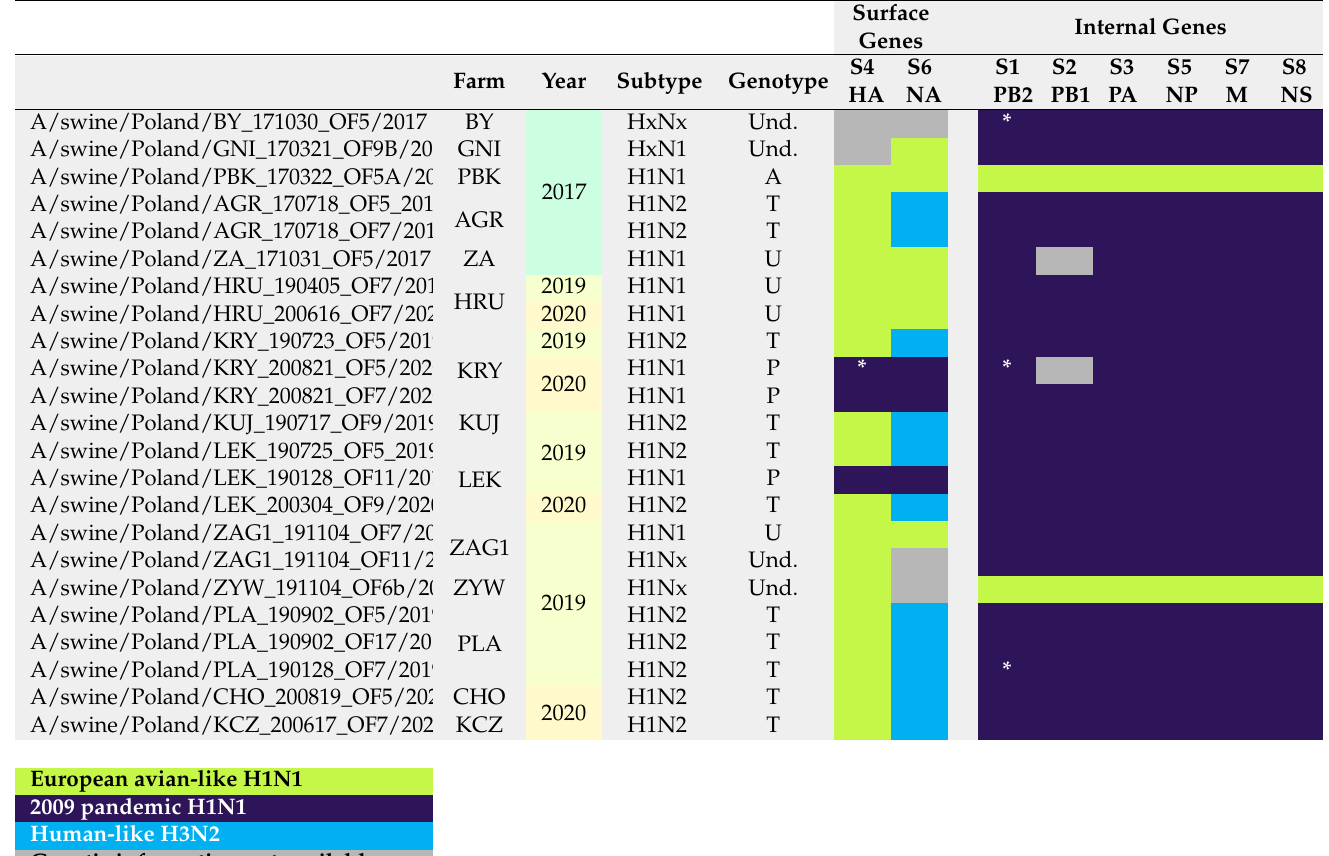
classified in the T genotype (11/19). This was followed by U (n = 4), P (n = 3), and A genotypes (n = 1). On a herd level this indicates that 58.3%, 25%, 16.7%, and 0.1% of all herds showed a T, U, P, or A genotype. Samples collected from the same farm in the same exemplified by the subtypes from herds AGR (2017), HRU (2019 and 2020), and PLA (2019) (Table 1). Only in the herd with the KRY T genotype (H1N1pdm09 ICG with Eurasian avian and A/swine/Gent/1/1984-like H3N2 origin for the HA and NA segment, respectively) was identified in 2019, after which the P genotype (H1N1pdm09 subtype) was detected in two samples originating from 2020. Table 1. Tabular overview of swIAV segment origin. Each segment of the complete (n = 17) and near-complete (n = 6) swIAV genomes were characterized to determine the origin of each swIAV segment. Classification and representation as adapted from Chepkwony et al. (2021), genotyping based on schemes described by Watson et al. (2015) and Henritzi et al. Asterisk (*) indicates segments with undefined nucleotide stretches (N >